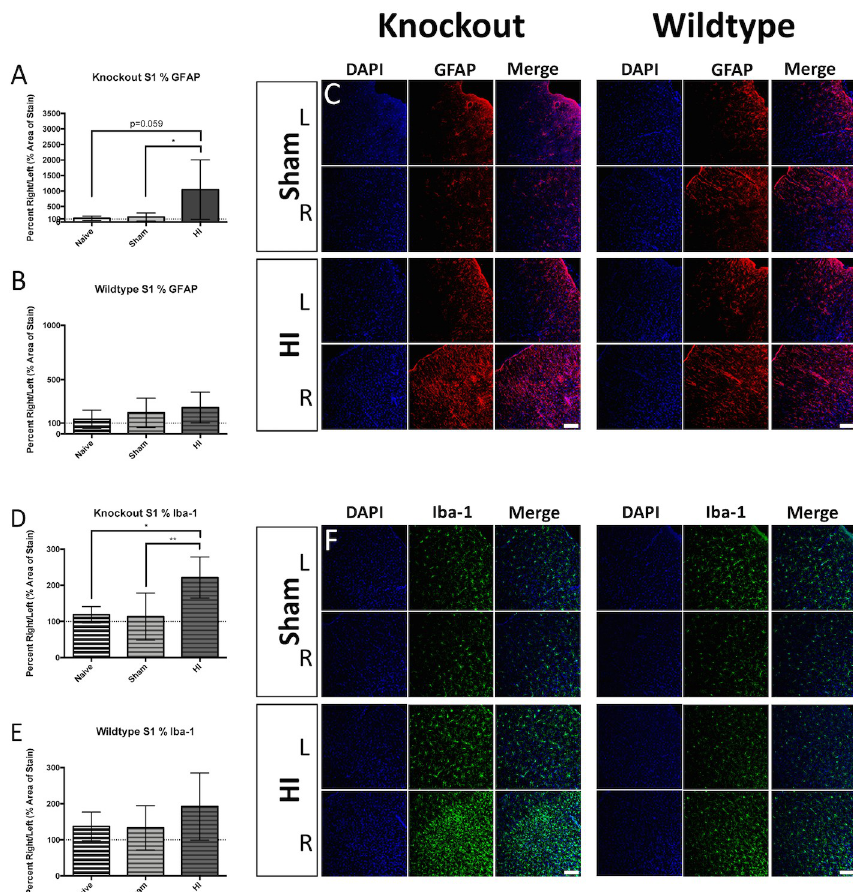
Fig 5. Somatosensory cortex gliosis. KO injured animals displayed a trend toward elevated stain area occupied by GFAP-positive signal when compared to uninjured controls (A), while WT injured animals did not (B). Representative immunofluorescence is depicted for KO Sham (C top left), KO injured (C bottom left), WT Sham (C top right), and WT injured (C bottom right) in the right and left hemispheres (blue = DAPI, red = GFAP). Percent area occupied by Iba-1-positive staining was elevated in KO injured animals when compared to uninjured controls (D), while stain area was not elevated in WT injured animals (E). Representative immunofluorescence is depicted for KO Sham (F top left), KO injured (F bottom left), WT Sham (F top right), and WT injured (F bottom right) in the right and left hemispheres (blue = DAPI, green = Iba-1). Scale bars = 100 μ m, 20x. Error bars = ± SD. � p < 0.05, �� p <